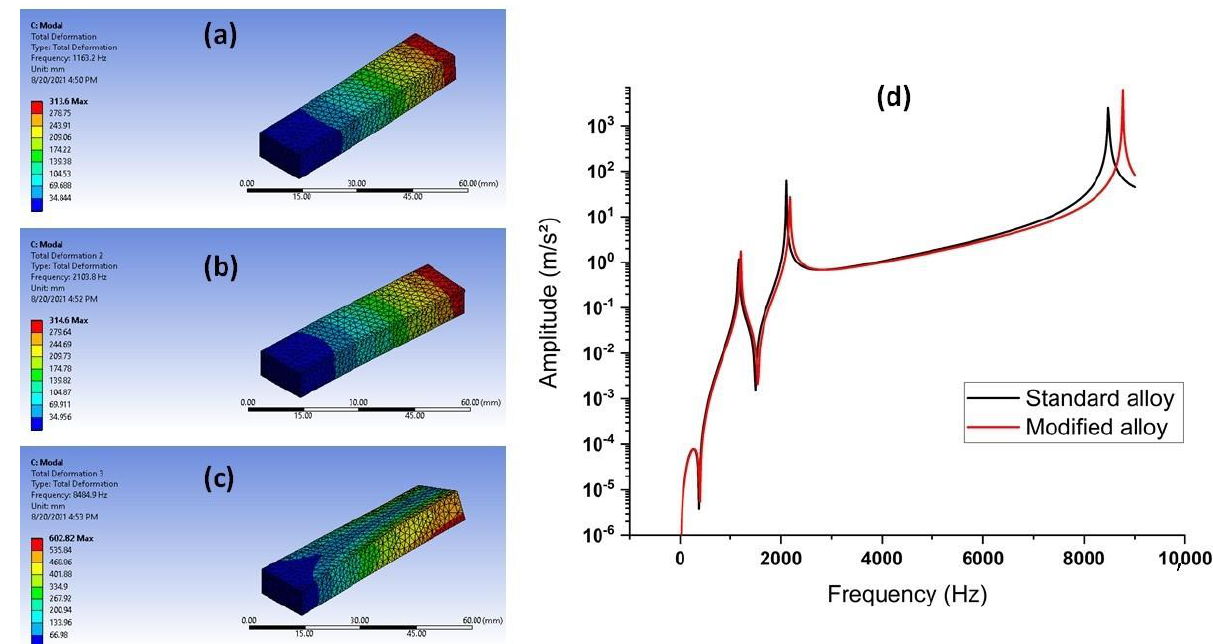
Figure 11. ( a ) First mode shape; ( b ) second mode shape; ( c ) third mode shape simulation analysis of the standard Al-2.5% Mg alloy; and ( d ) simulation of modal analysis for the studied alloys using FRF representation. Table 3. The eigenvalue of the resonant frequencies at the first six